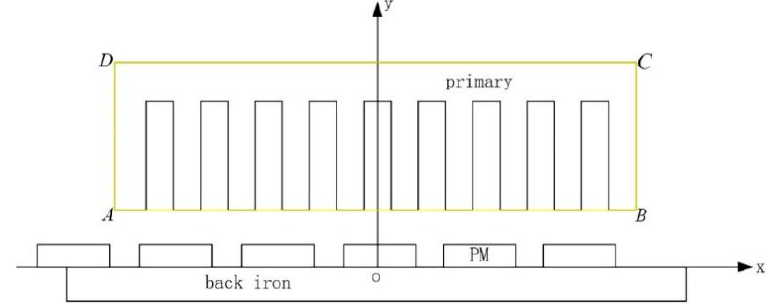
Figure 5. PMLSM integration path.